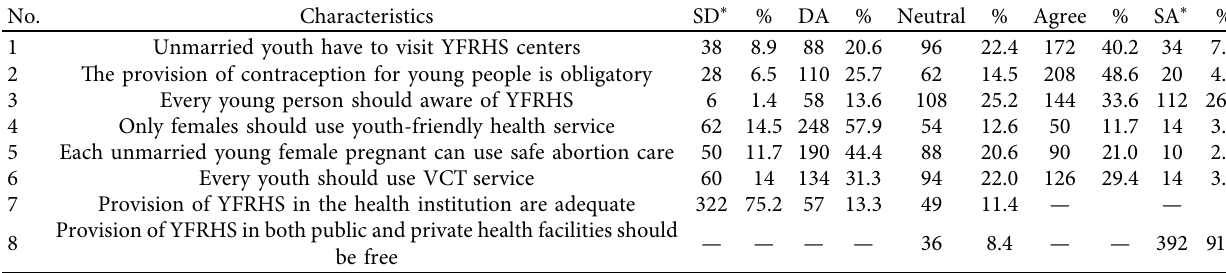
Table 3: Attitudes of students towards youth-friendly health service ( n � 428).